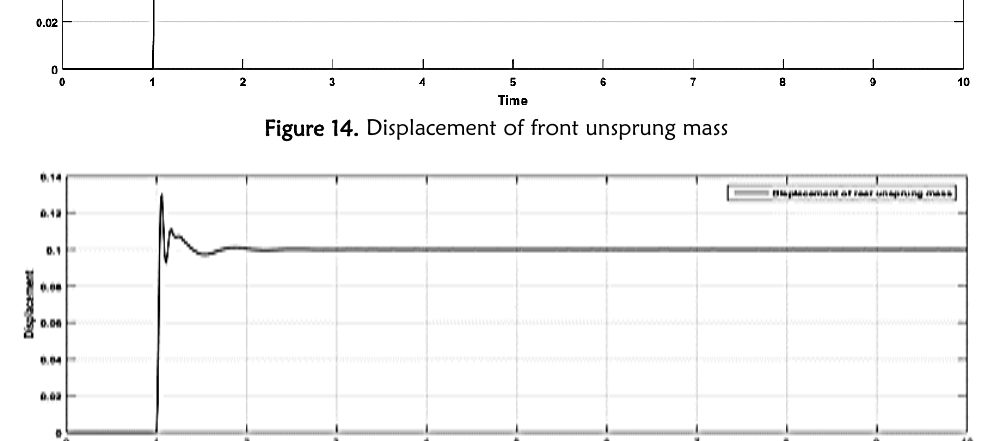
Figure 14. Displacement of front unsprung mass